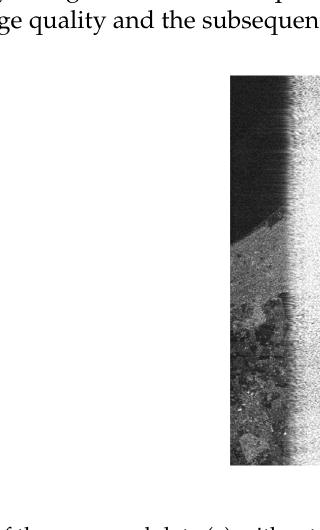
( b ) Figure 13. RFI detection results of the measured SAR data corrupted with simulated RFI: ( a ) the variation of optimal threshold with different false alarm levels. ( b ) the RFI detection result at a false alarm rate of